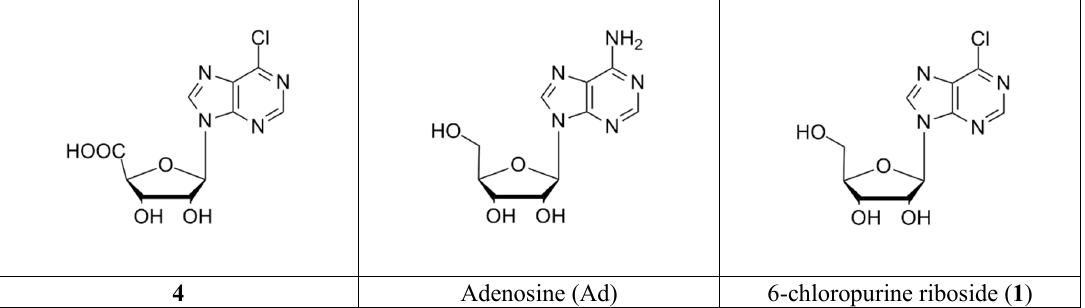
Table 1. Percentage (%) of de-coloration of the DPPH solution and IC 50 values in μ g/mL for synthetic compounds in comparison to ascorbic acid. Values are averages of triplicate experiments.